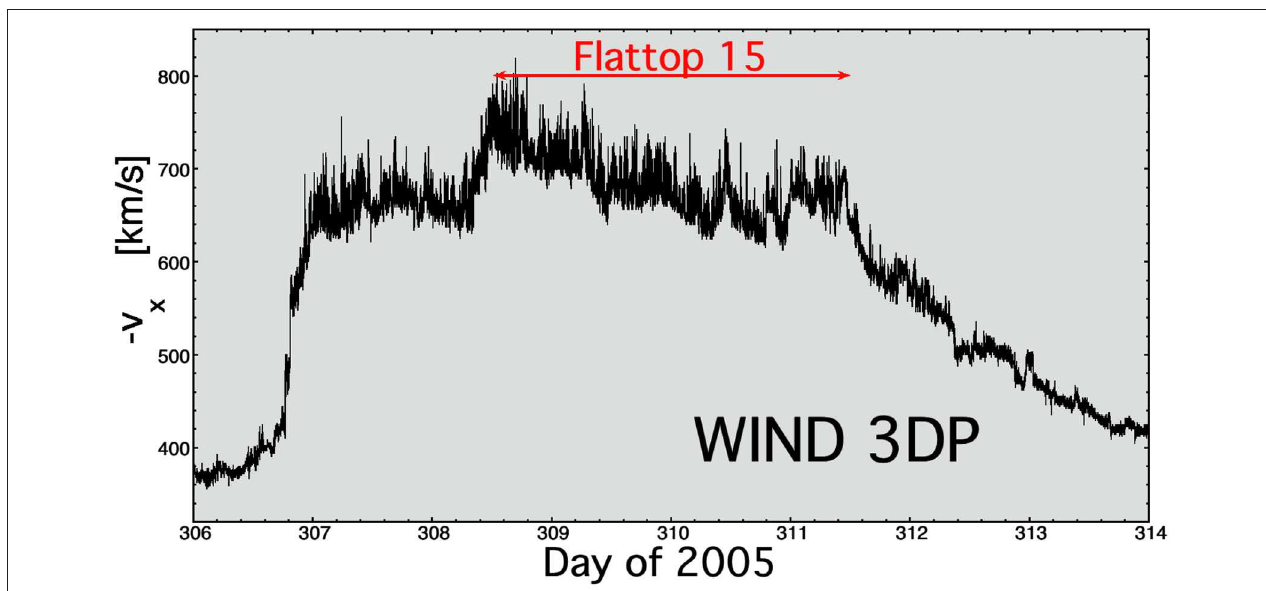
FIGURE 1 | The high-speed stream in November 2005 that contains Flattop 15. The radial-velocity measurements were taken by the WIND spacecraft at